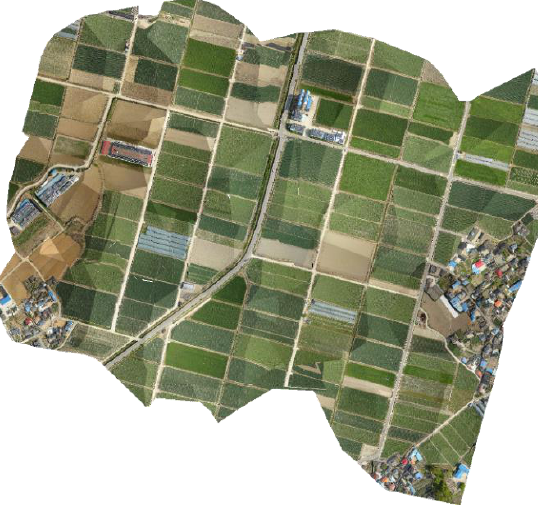
Figure 11. Result of the proposed method